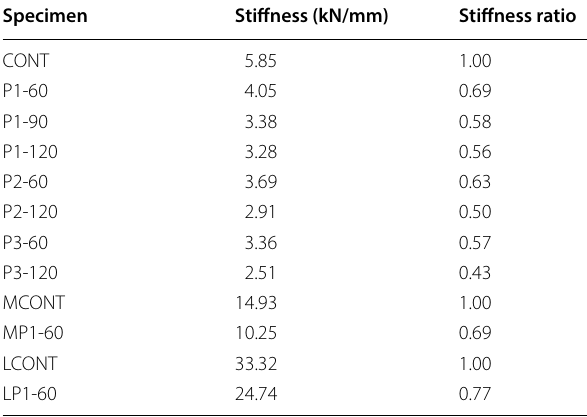
Table 5 Temperatures and deflection during the fire test.